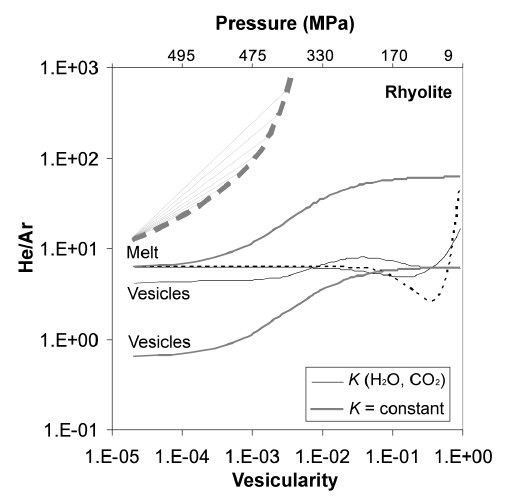
Fig. 14. He/Ar fractionation during closed system degassing of rhyolitic melt at 1000°C. Curves as in fig. 13. In the calculation using the model by Nuccio and Paonita (2001), initial conditions were 40 mol% CO 2 in H 2 O-CO 2 mixed vapor (noble gases are com- puted as minor species) at 500 MPa pressure. The higher amount of dissolved water (6 wt%) in respect of the basaltic melt amplifies the discussed water ef- fect, causing very low He/Ar fractionation.